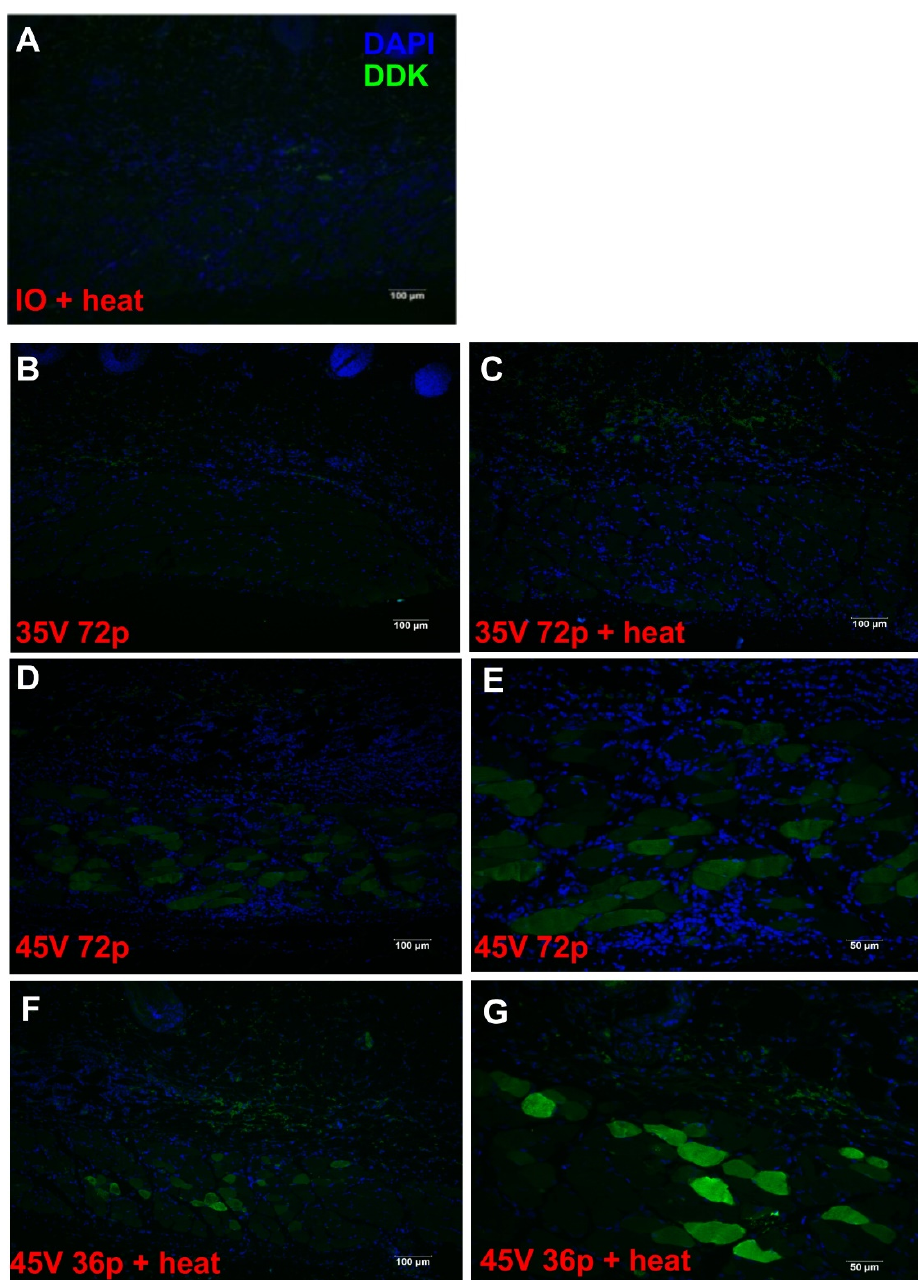
Figure 5. Expression distribution of moderate heat-assisted GET to the skin using gWizLuc-myc- DDK. ( A ) injection only plus heat (IO + heat); ( B , C ) injection of pDNA followed by 72 pulses at 35 V at ambient (35 V 72p) or after the application of moderate heating (35 V 72p + heat); ( D , E ) 72 pulses at 45 V (45 V 72p) applied at ambient; and ( F , G ) 36 pulses at 45 V after the application of moderate heat from an infrared laser (45 V 36p + heat). ( A – D , F ) 100×, scale bar = 100 μ m. ( E , G ) 200×, scale bar = 50 μ m.